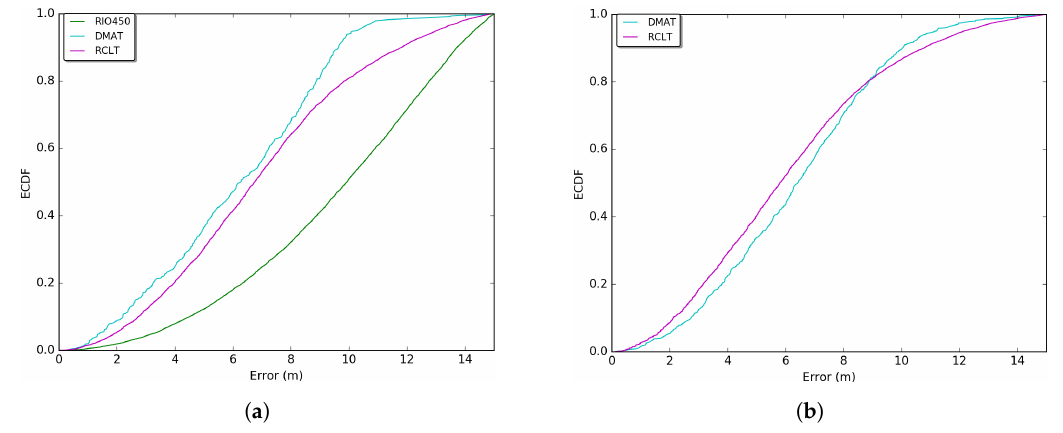
Figure 8. Empirical Cumulative Distribution Function (ECDF) of the real GPS errors retrieved from the datasets. ( a ) GPS errors on the entrance exit sense; ( b ) GPS errors on the exit entrance sense.